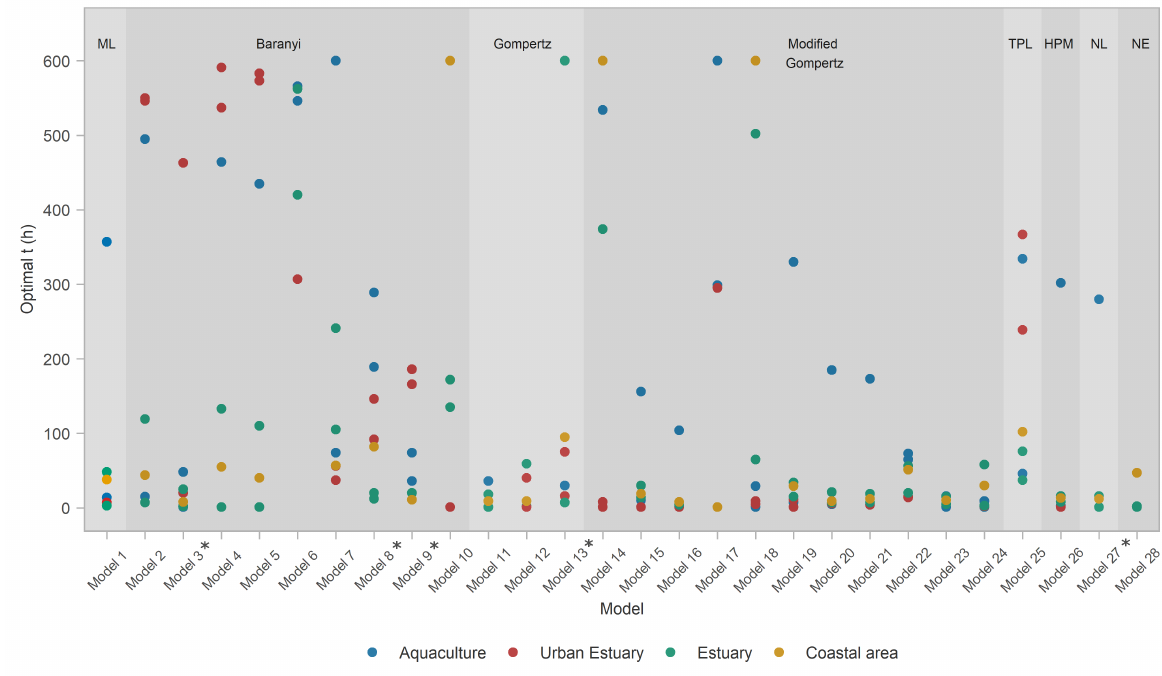
Figure A2. Optimal run time for the simulation duration that produces the best match between the model prediction and the observation (data point of a dataset) based on R 2 median value. Models based on Table 4 are specified on the x axis. Primary models are labeled as follows: ML—modified logistic, Baranyi, Gompertz, modified Gompertz, TPL—three-phase linear, HPM—Huang primary, NL—no-lag, and NE—net exponential. Star (*) signifies models that had an evaluation issue with some of the data points in some of the datasets (details in Appendix